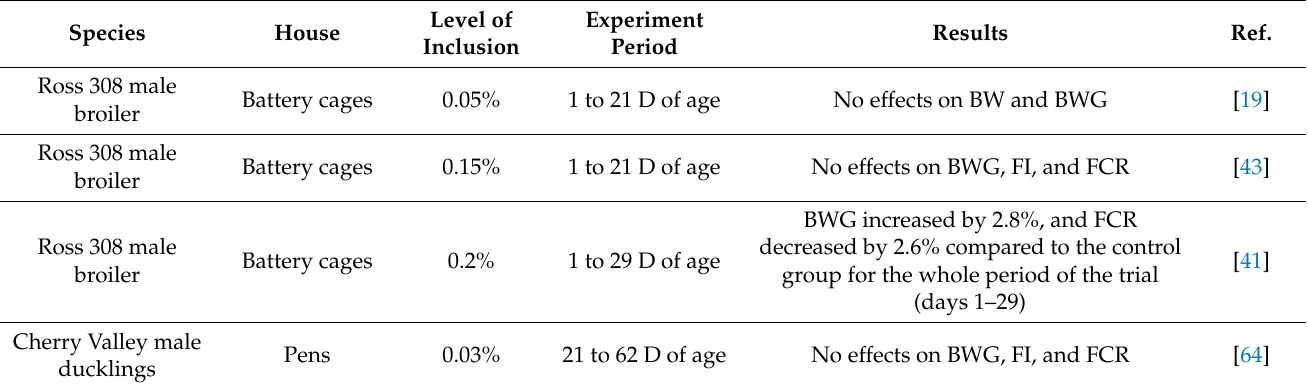
Table 3. MSM inclusion in diets and effect on growth performance traits in comparison with control used in different